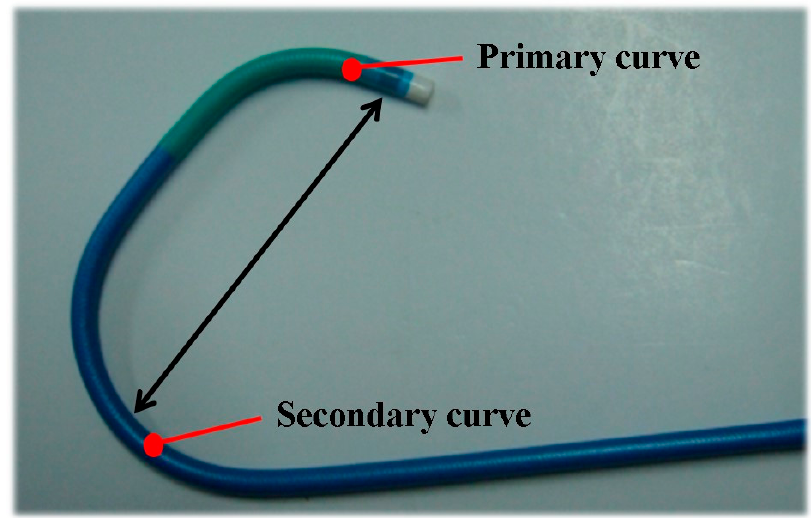
Figure 1. Tip of the Judkins left catheter. The numbers (e.g., JL 3.5) indicating the size of the Judkins left catheter means the length of the primary to the second curve.